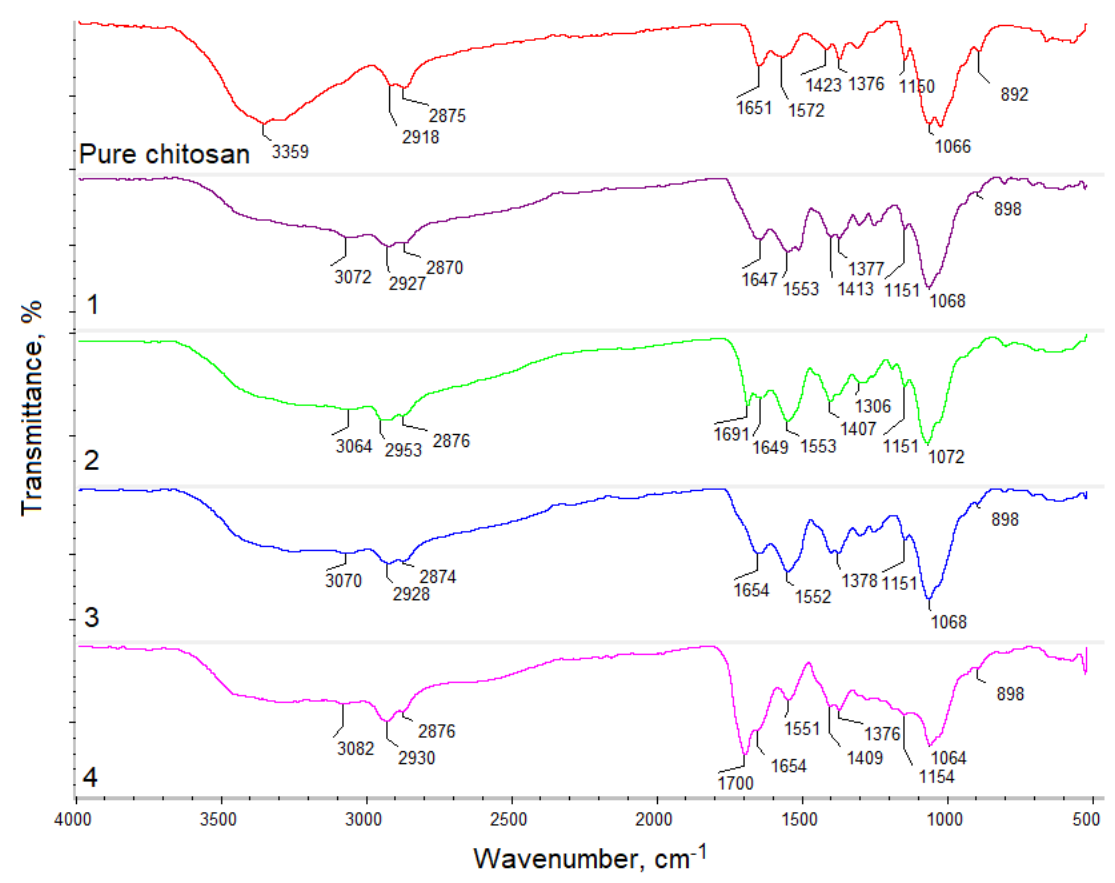
Figure 2. FT–IR analysis of the pure chitosan and obtained samples.